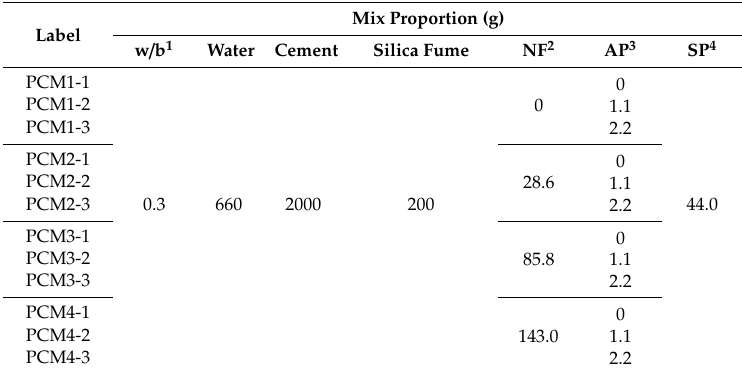
Table 1. Mix proportions of porous cementitious